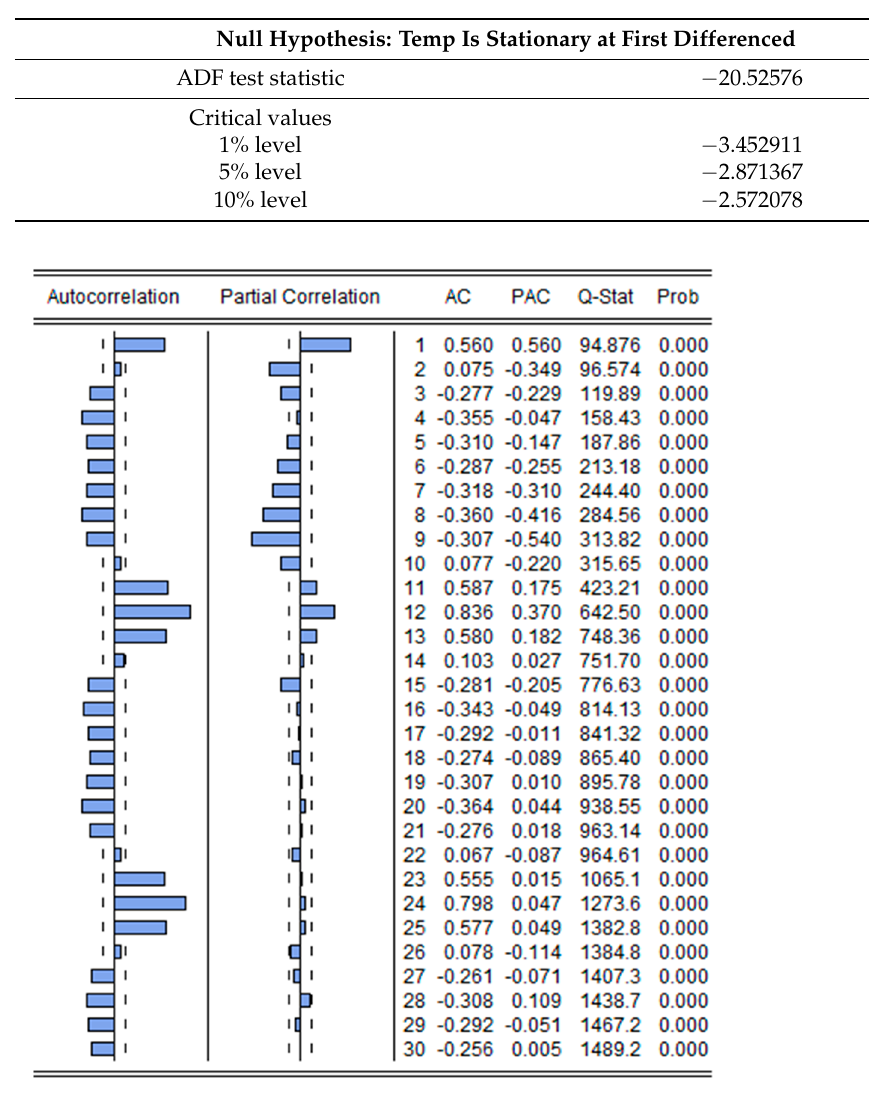
Table 2. The values of unit test of training dataset. Null Hypothesis: Temp is Stationary at First Differenced